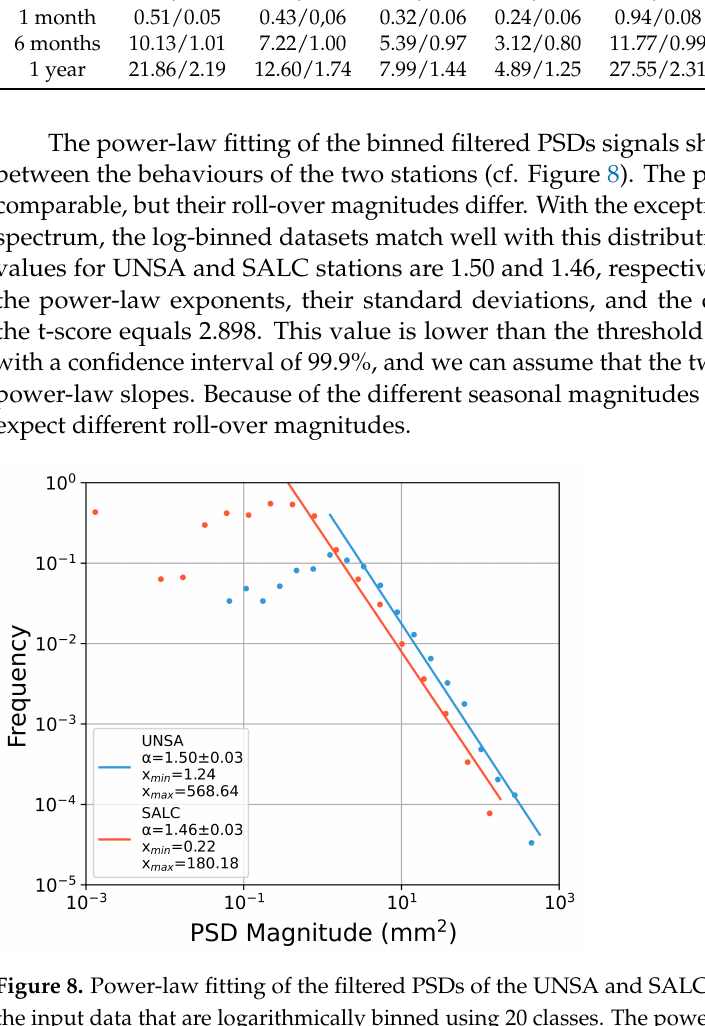
Table 2. Amplitude estimation of various harmonics for the stations along the E-W and N-S profiles. Absolute and Std.-Normalized Amplitude (mm/ − ) Period UNSA GOLG SRSA SALC JBAL TUCU